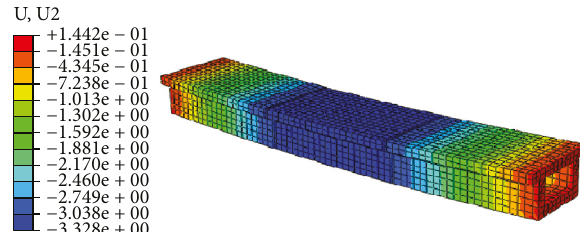
Figure 9: Nephogram of midspan deflection of test